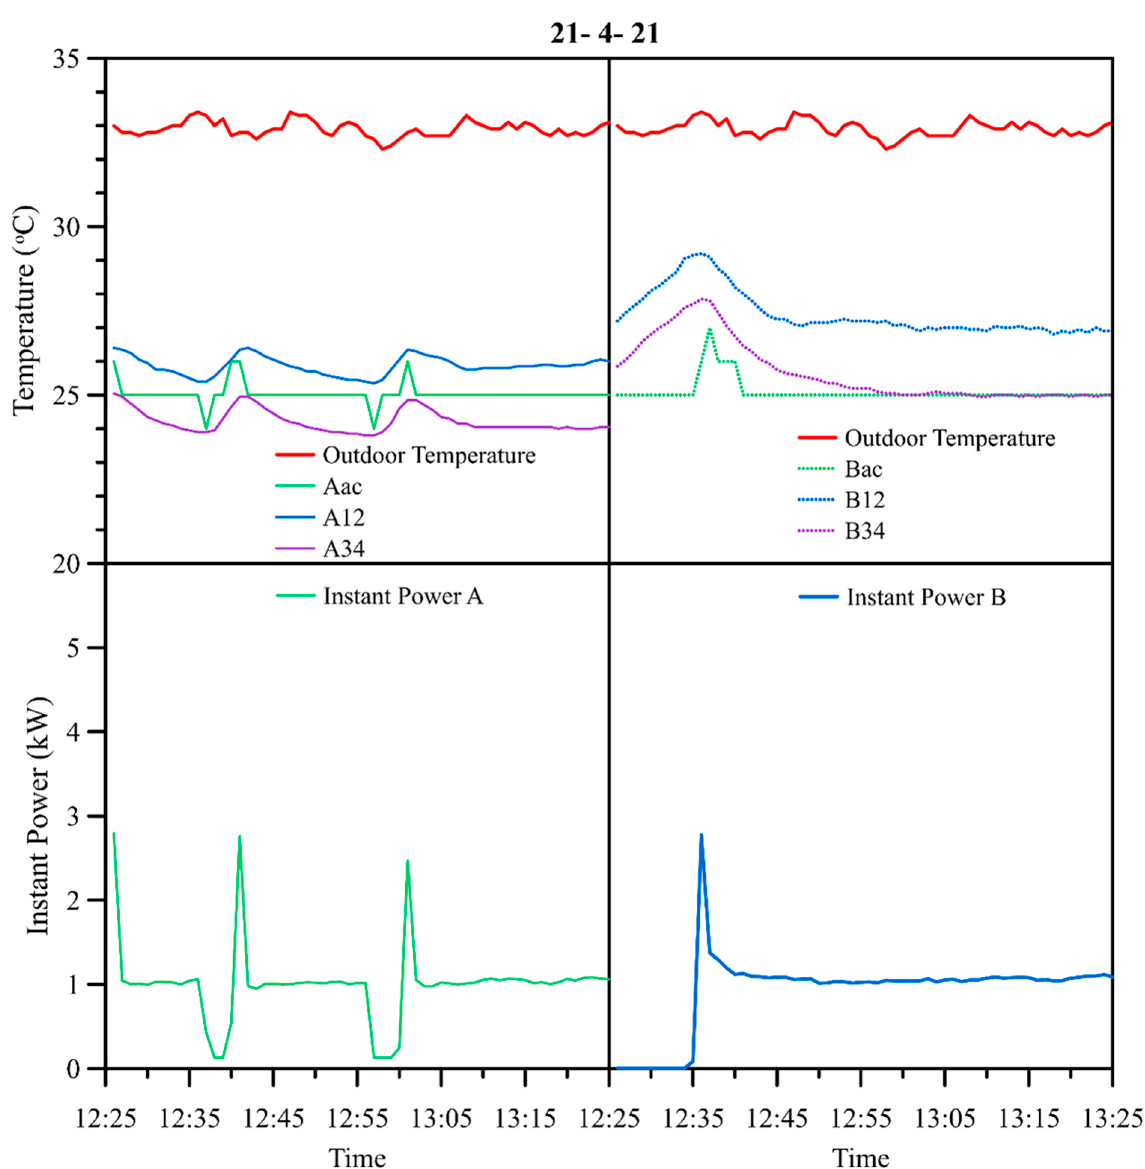
Figure 9. Temperature and instant power consumption of rooms A and B at 12 to 13.